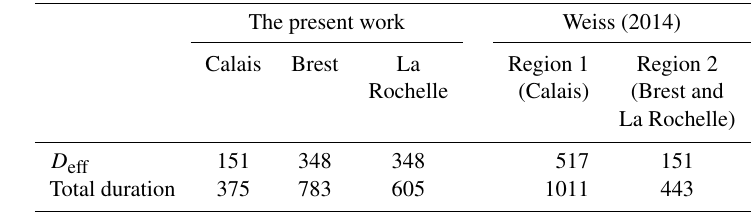
Table 1. Comparison of total and effective durations of observations (years) used in the present study with those used by Weiss (2014). The effective duration of observations takes into account the intersite dependence. A total duration of observations is the sum of all on-site durations in the region of interest (without intersite dependence).